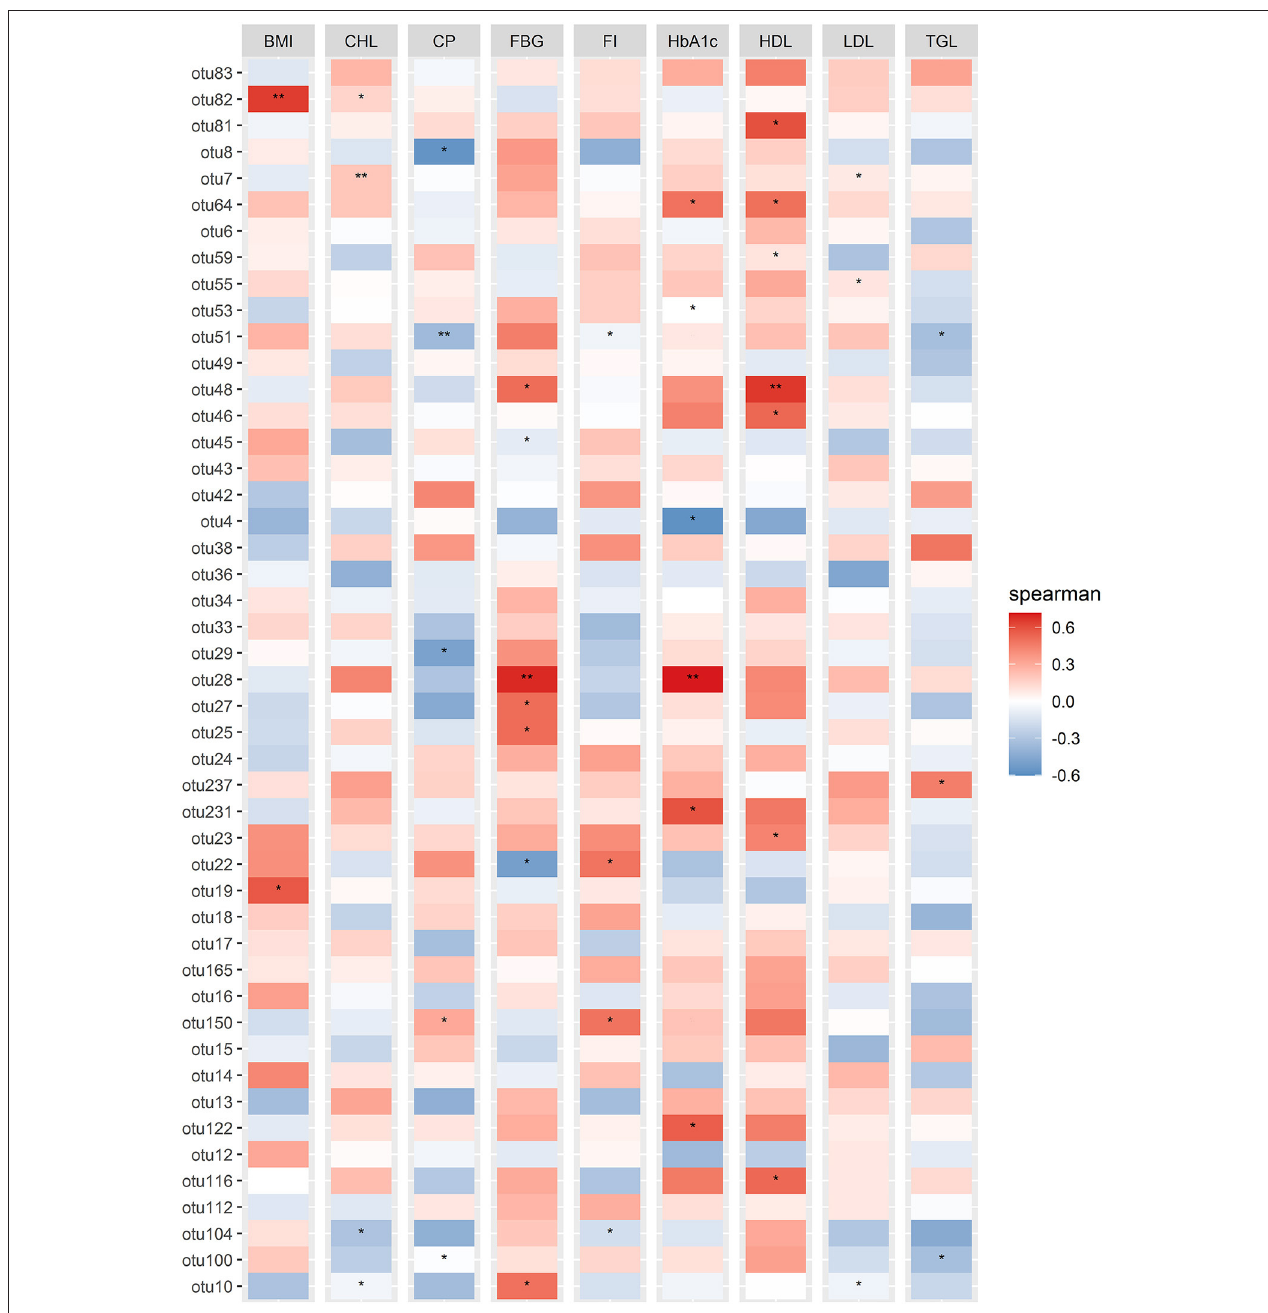
FIGURE 5 | Correlation Heatmap of physiological parameters with the significant differential abundant OTUs identified in DotPlot analysis. Spearman correlation analysis based on differentially abundant significant OTUs and the measured physiological parameters. Spearman correlation values were shown in the vertical heatmap panel to the right. P ≤ 0.05 were indicated by the “*”